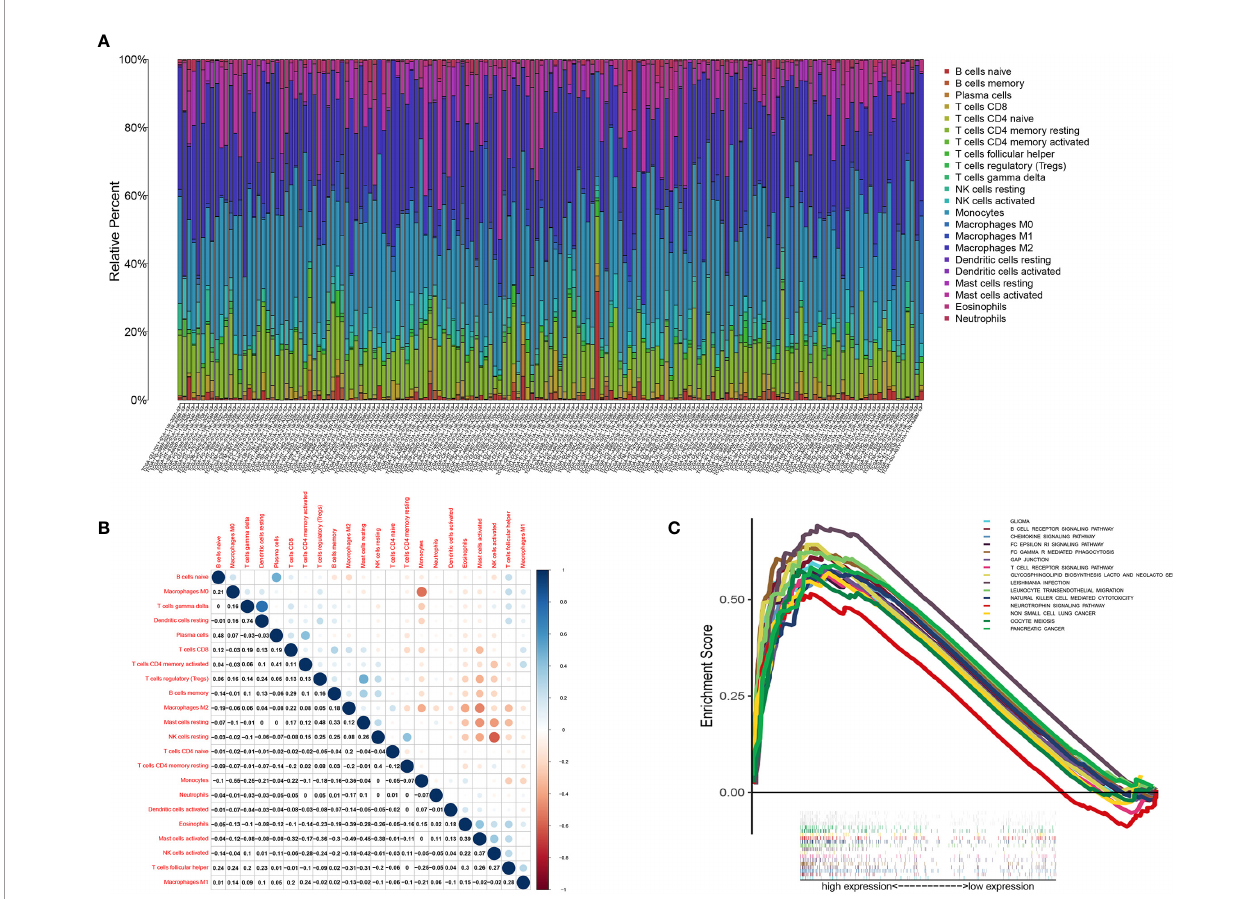
FIGURE 9 | TIC pro fi le in tumor samples and correlation analysis. (A) Barplot showing the proportion of 22 kinds of TICs in LGG tumor samples. Column names of plot were sample ID. (B) Heatmap showing the correlation between 22 kinds of TICs and numeric in each tiny box indicating the p value of correlation between two kinds of cells. The shade of each tiny color box represented corresponding correlation value between two cells, and Pearson coef fi cient was used for signi fi cance test. (C) GSEA for samples with high CD3E